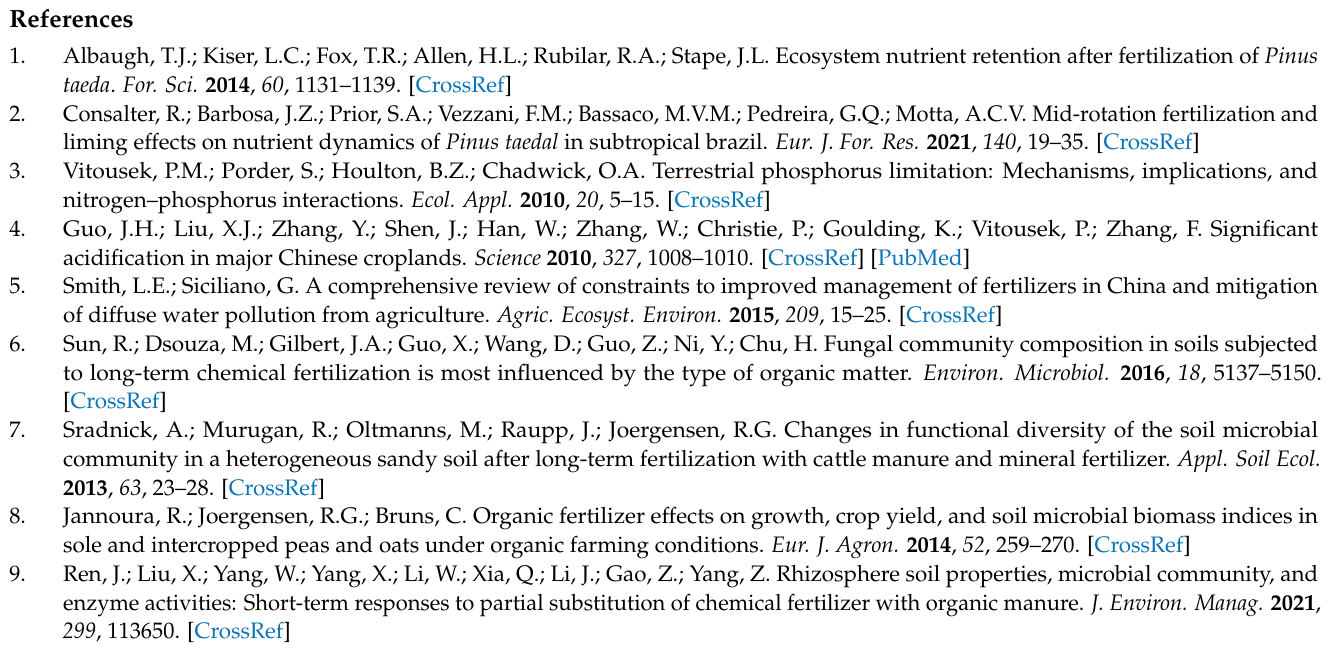
Different lower letters indicate the significant differences among four fertilizer regimes ( p < 0.05); Figure S3: Soil physiochemical and root-exudate-related drivers of the ecological functions of soil bacteria and the fungal guilds. Both bacterial functions and fungal guilds were correlated to soil variables by partial Mantel tests based on the Bray–Curtis distance. Pairwise comparisons of soil physiochemical properties and root exudates are shown at the upper-right, with a color gradient representing Spearman’s correlation coefficients. The edge width represents the partial Mantel’s r statistic for the corresponding correlation, and the edge color denotes that significance was tested based on 999 permutations. SOC, soil organic carbon; TN, soil total nitrogen; TP, soil total phos- phorus; TK, soil total potassium; AN, soil available nitrogen; AP, soil available phosphorus; α Cop, α -Copaene; Cal, Calarene; dLim, D-Limonene; aFen, α -Fenchene; Gua, Guaiol; aSan, α -Santalene; Ses, sesquiterpenes; Mon, monoterpenes; Fur, furan; Alc, alcohols; Est, esters. Table S1: Relative abundance (%) of dominant genera of rhizosphere soil bacteria and